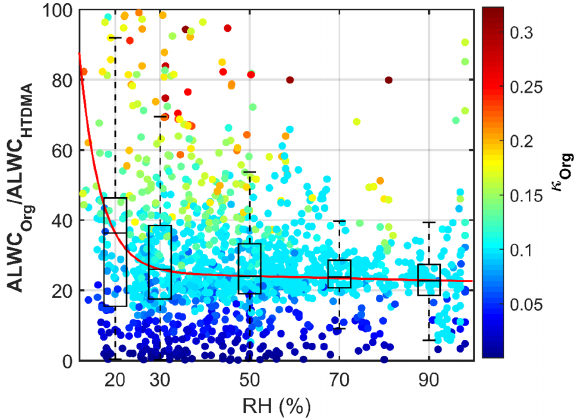
Figure 4. The variation of the fraction of ALWC Org in total ALWC (ALWC HTDMA ) with the ambient relative humidity (RH). The color of the dots denotes the hygroscopicity parameter of or- ganics ( κ Org ). The boxes show the fraction of ALWC Org with the 25th, 50th and 75th percentiles. The extremities show the 5th and 95th percentiles. The red line shows the fitting curve with the function y = ae bx